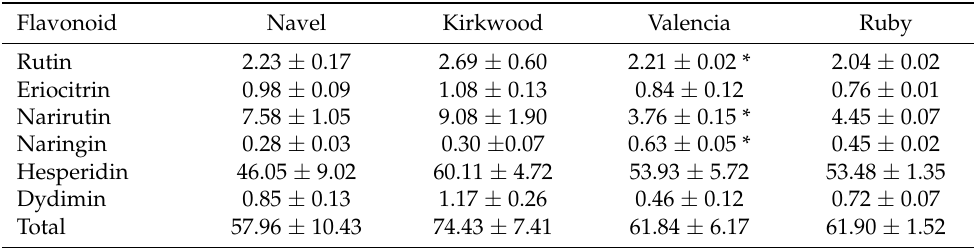
Results are the mean of two biological replicates ± SD. Asterisks indicate significant differences between the red-fleshed oranges, K and R and the ordinary varieties, N and V, respectively ( p ≤ 0.05, t